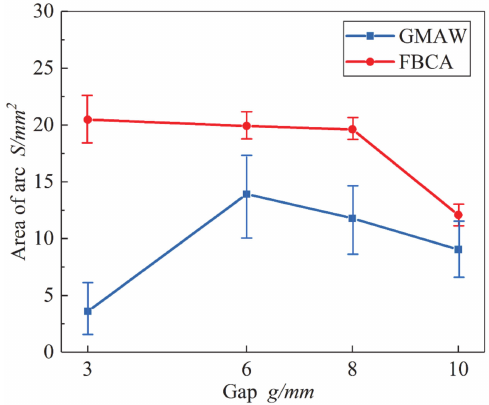
Figure 11. Influence of groove gaps on area of welding